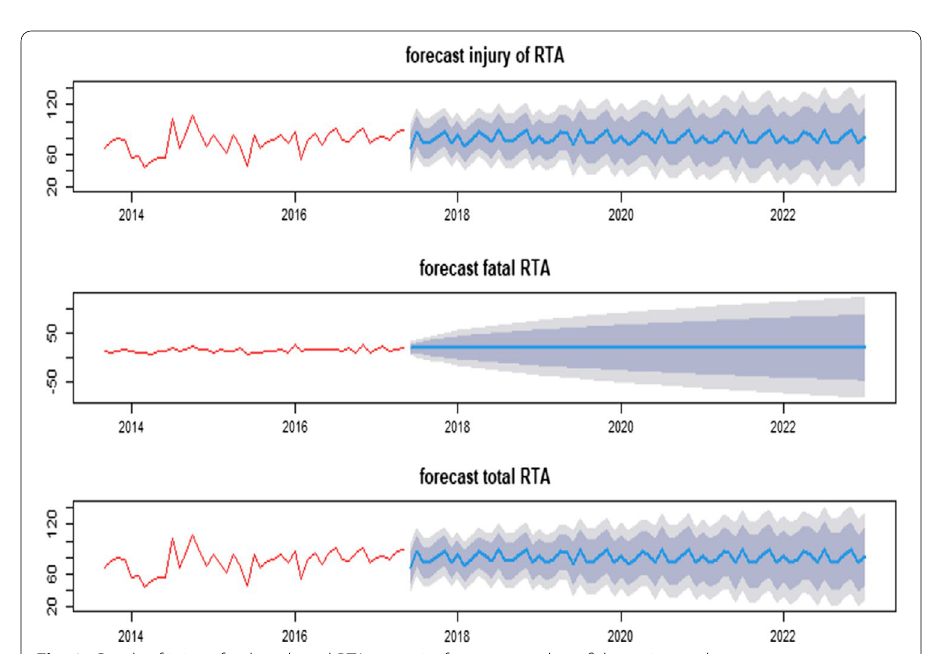
Fig. 8 Graph of injury, fatal, and total RTA cases, its forecasts, and confidence